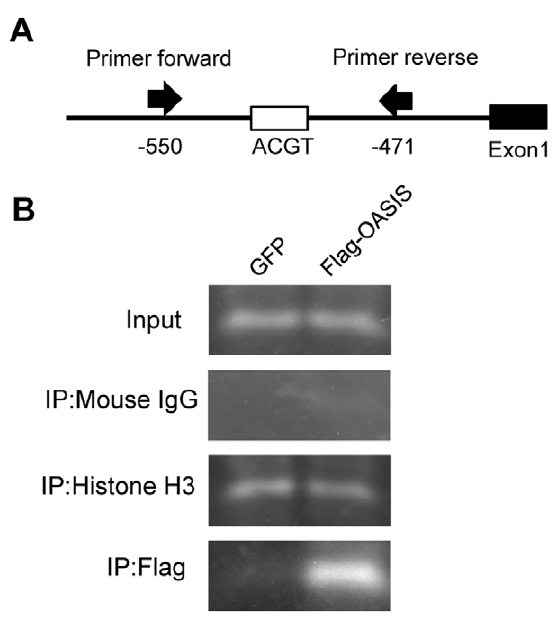
Table S1 RT-PCR primer sequences. The following table indicates sets of primers used for RT-PCR.